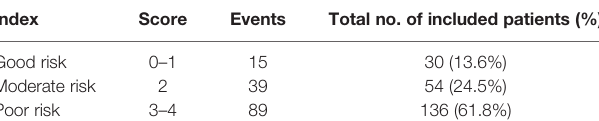
TABLE 3 | Prognostic index.